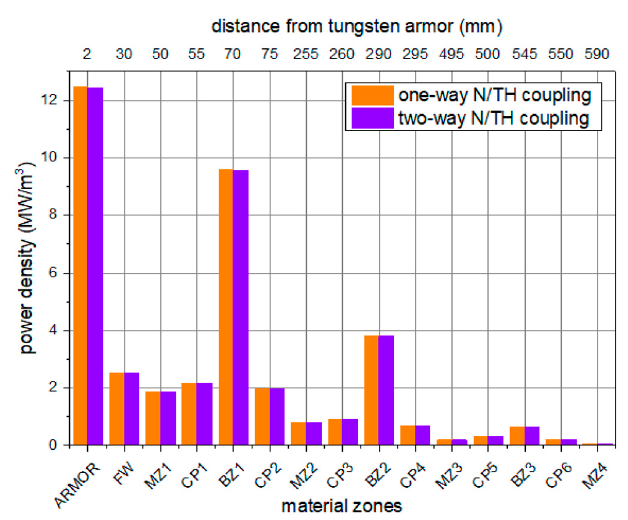
Figure 15. Radial power density distribution of the HCSB blanket.